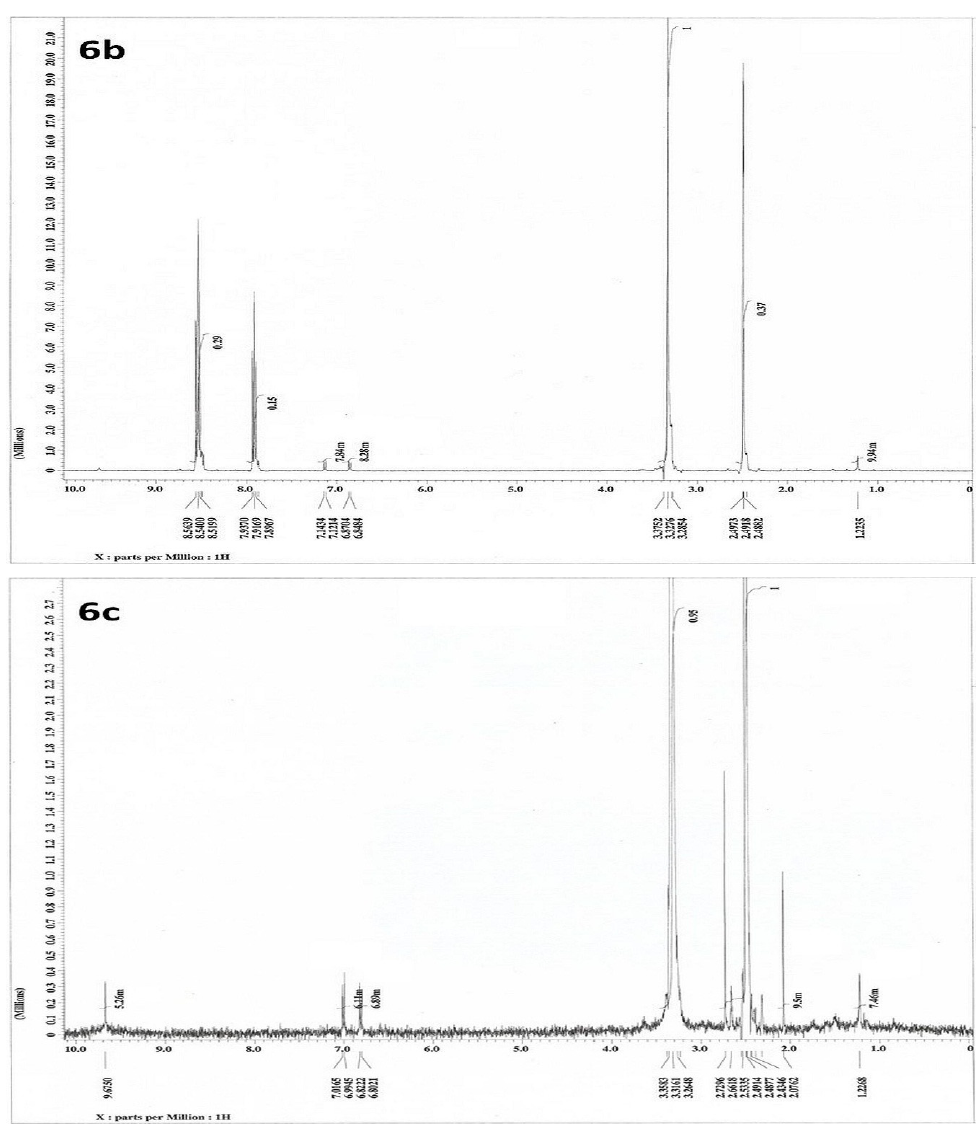
Figure 3. 1 H ‐ NMR spectrum of 6a , 6b and 6c . Figure 3. 1 H-NMR spectrum of 6a , 6b and 6c